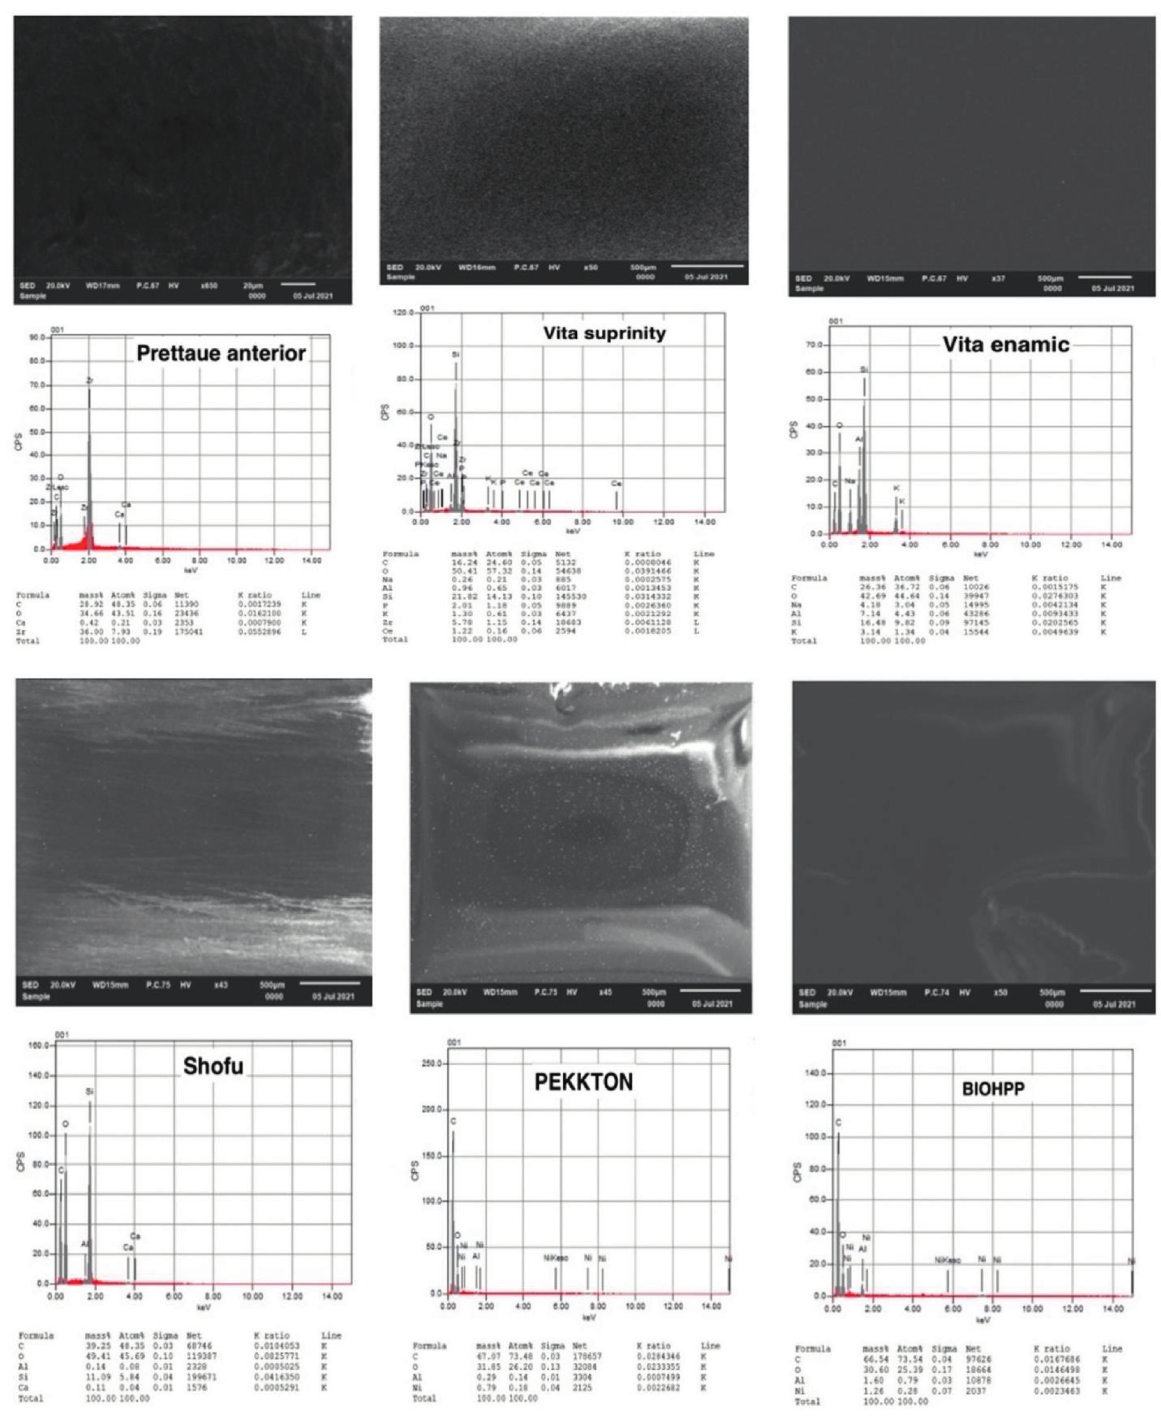
Figure 2: Representative EDX spectrum of the surface of CAD/CAM restorative materials